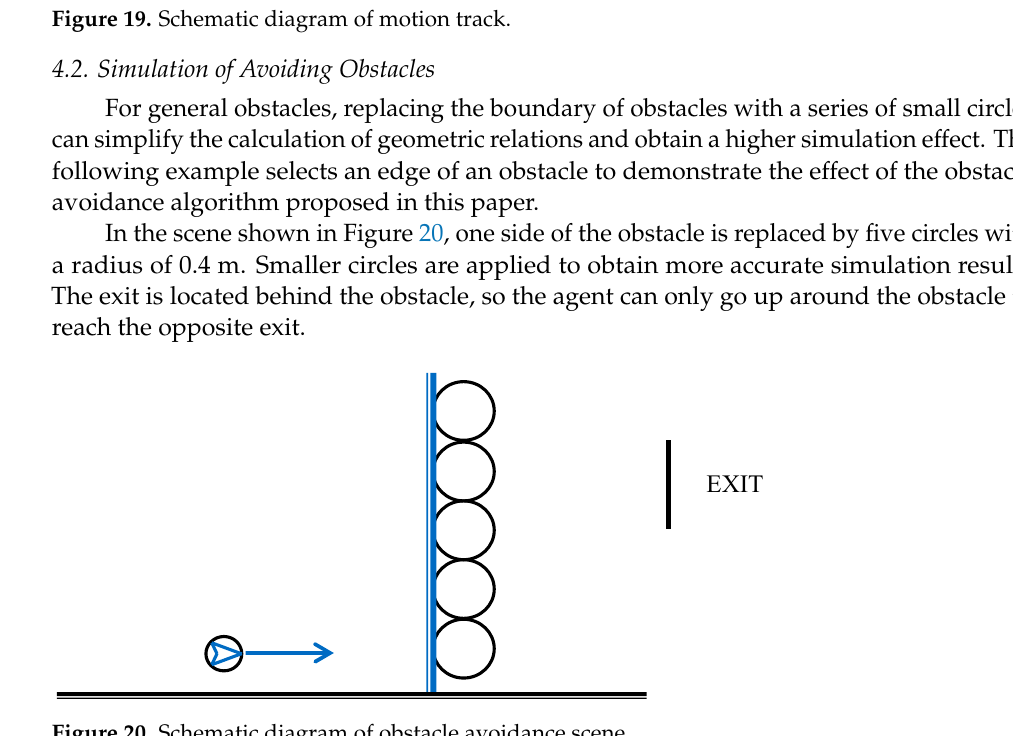
Figure 20. Schematic diagram of obstacle avoidance scene.